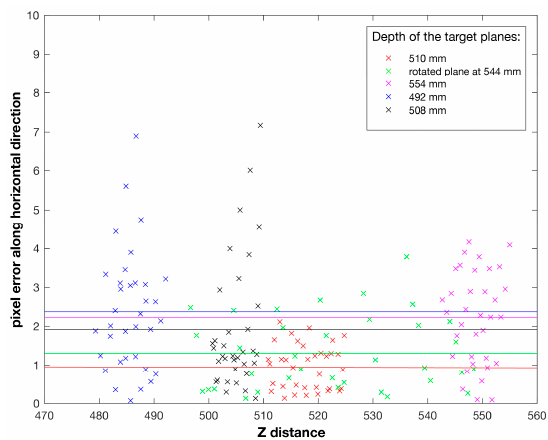
Figure 9. Horizontal monoscopic disparities for the target planes around z = 500 mm. The coloured lines are the mean pixel errors on the u coordinate for each target plane. Table 1. Mean and standard deviation of horizontal monoscopic disparities between direct-view and VST views of the target planes.